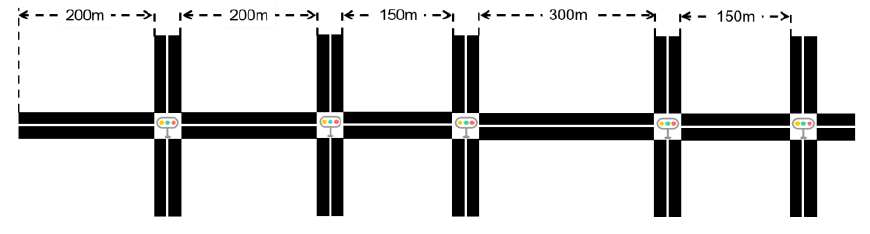
Figure 6. The simulation scenario.